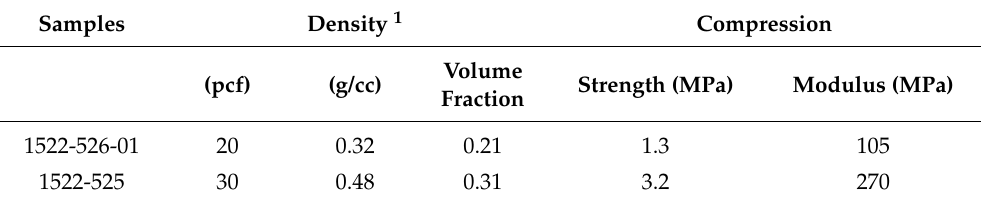
Table 1. Density and load characteristics of the used